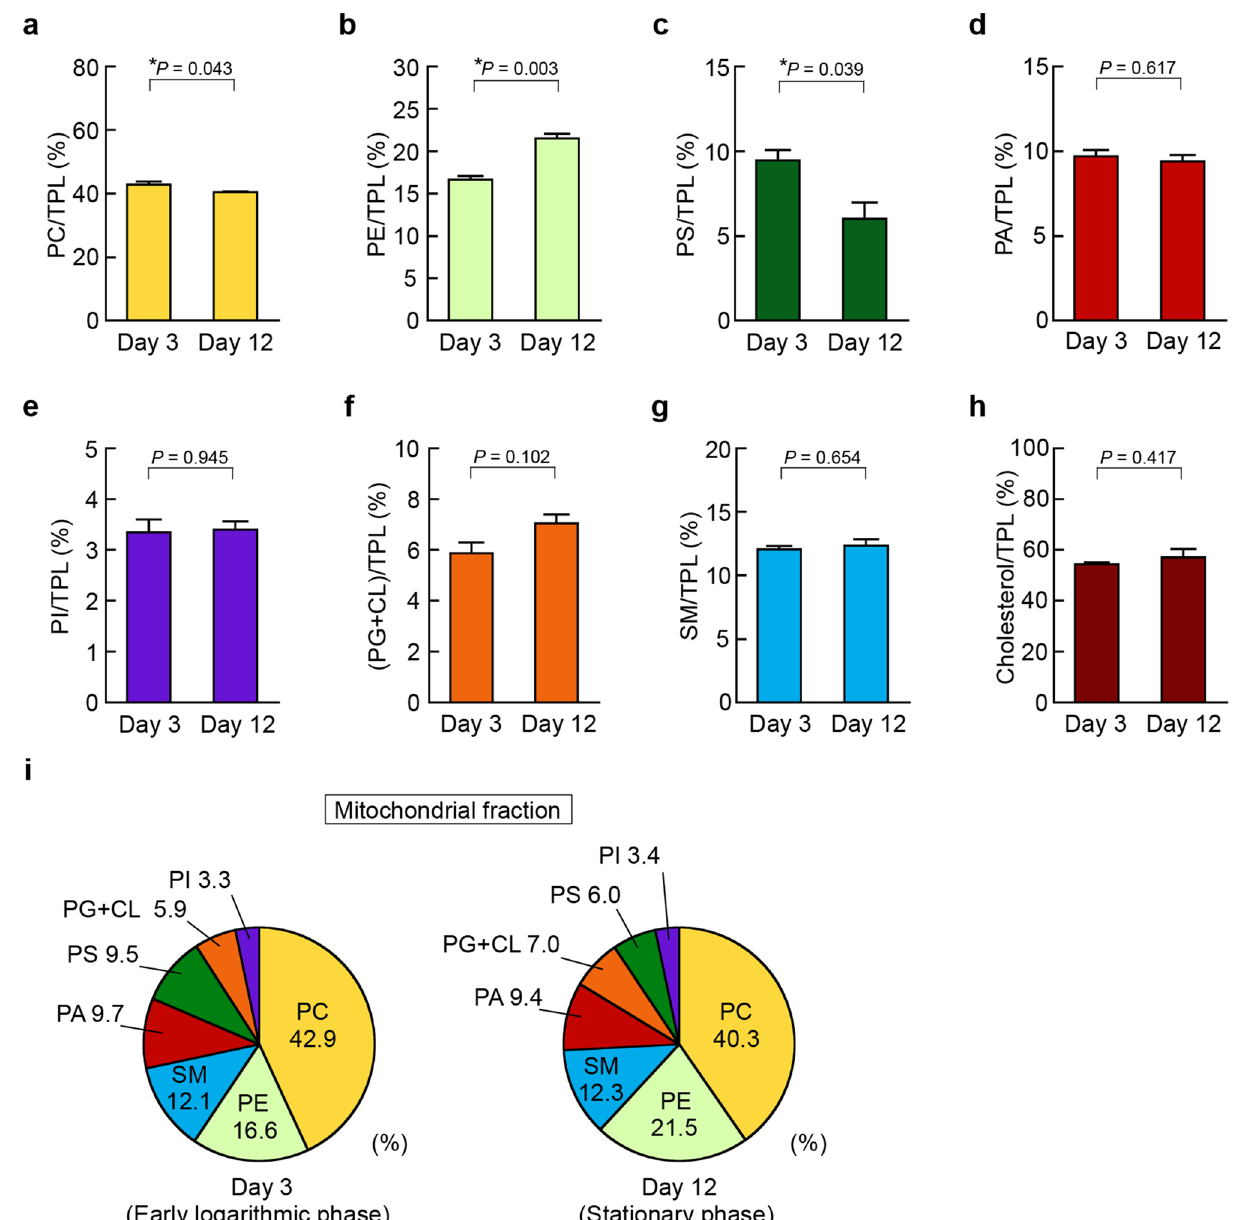
Figure 7. Alteration of mitochondrial phospholipid composition in HepG2 cells during cell growth. HepG2 cells were seeded at a cell density of 5.0 × 10 4 cells/cm 2 in 150-cm 2 flasks and cultured in DMEM containing 10% FBS at 37 °C for the indicated days. At Day 3 (early logarithmic phase) and Day 12 (stationary phase), mitochondrial fractions were isolated from the cells and mitochondrial lipids were extracted. The total phospholipid (TPL) content was calculated as the sum of PC, PE, PS, PA, PI, PG + CL, and SM contents. The ratios of PC/TPL ( a ), PE/TPL ( b ), PS/TPL ( c ), PA/TPL ( d ), PI/TPL ( e ), (PG + CL)/TPL ( f ), SM/TPL ( g ) and cholesterol/TPL ( h ) in the mitochondrial fractions purified from the cells at Day 3 and Day 12 were determined by the enzymatic measurements (mean ± S.E., n = 3, * P < 0.05, significantly different between Day 3 and Day 12, unpaired two-tailed Student’s t -test). ( i ) The phospholipid compositions of the purified microsomal fractions from HepG2 cells at Day 3 and Day 12 are shown as pie export of mitochondrial PE to other organellar membranes and the import of PS to mitochondrial membranes were suppressed in the stationary phase. The counter-transport of PS and PI(4)P between the ER and plasma membranes is mediated by oxysterol-binding protein-related proteins 5 and 8, which have also been reported to be localized to the ER-mitochondria contact sites 60,61 . However, the mechanism underlying the translocation of PE and PS between mitochondria and other organelles is largely unclear. The production of PA from PC is catalyzed by the membrane-bound PLDs. PLD1 is localized to the peri- nuclear region, Golgi, ER and late endosomes, whereas PLD2 is localized to the plasma membrane 29,50 . The